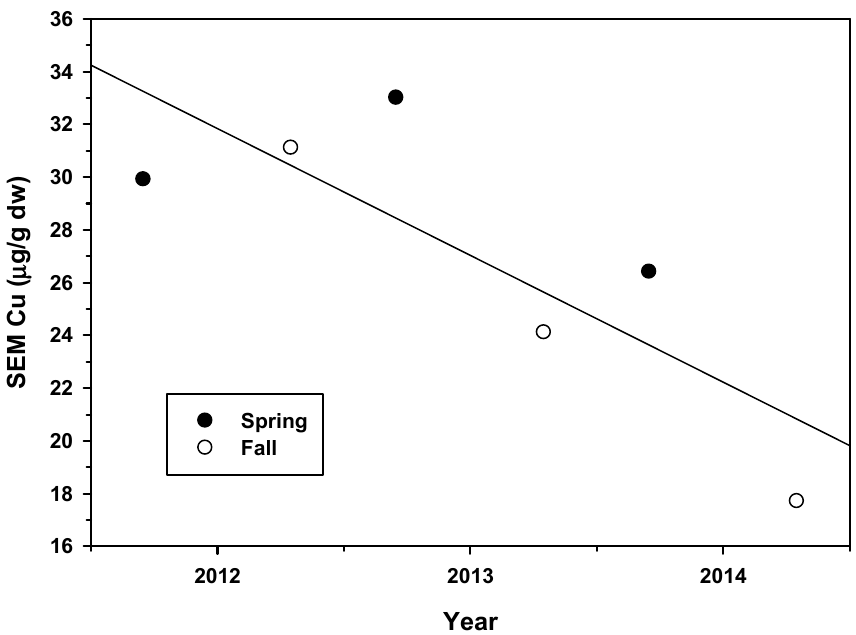
Figure 15. Regression results of sediment SEM copper concentrations (µg/g dry wt) from spring and fall sediment sampling at Cache Slough site CS-09 for the years 2012, 2013 and 2014. (r 2 = 0.545, p = 0.094).